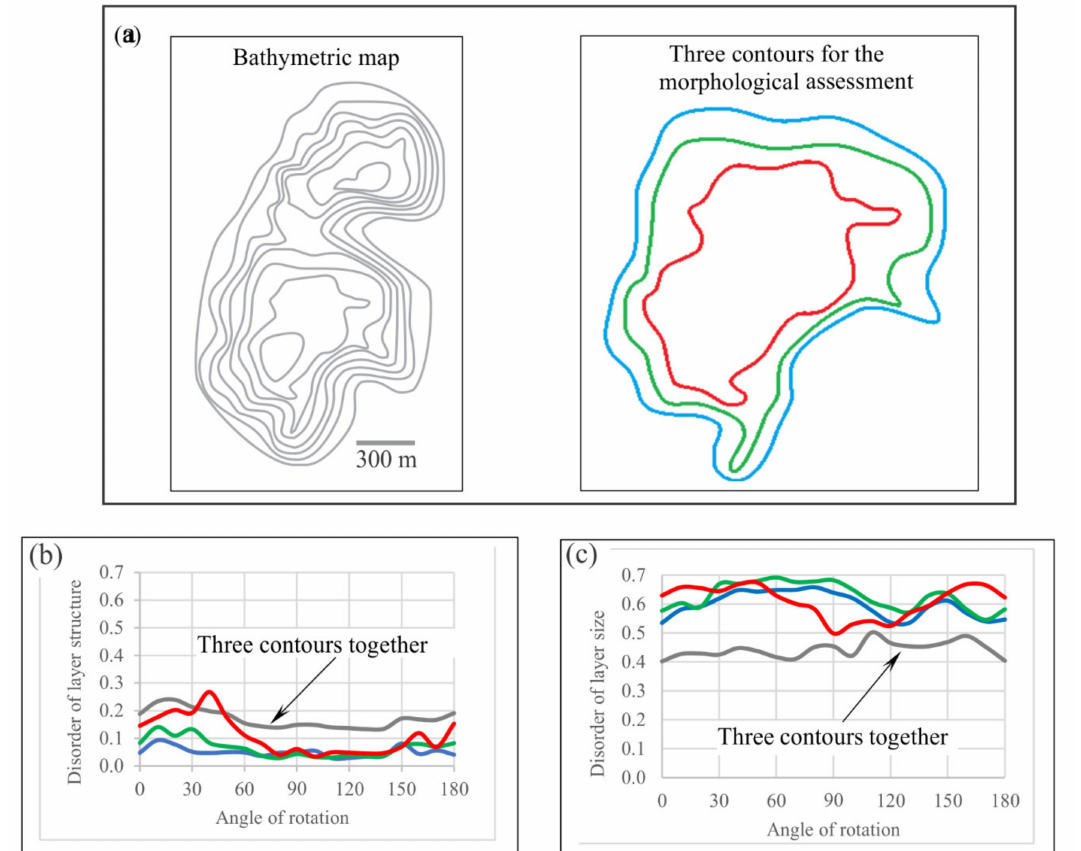
Figure 14. Non-additive morphological characteristics of contours. ( a ) Contours for the morphological assessment. ( b ) Disorder of layer structure parameter for all and isolated contours. ( c ) Disorder of layer size parameter for all and isolated contours. Credit: Map created by April Behr [40]. Alaska Department of Fish and